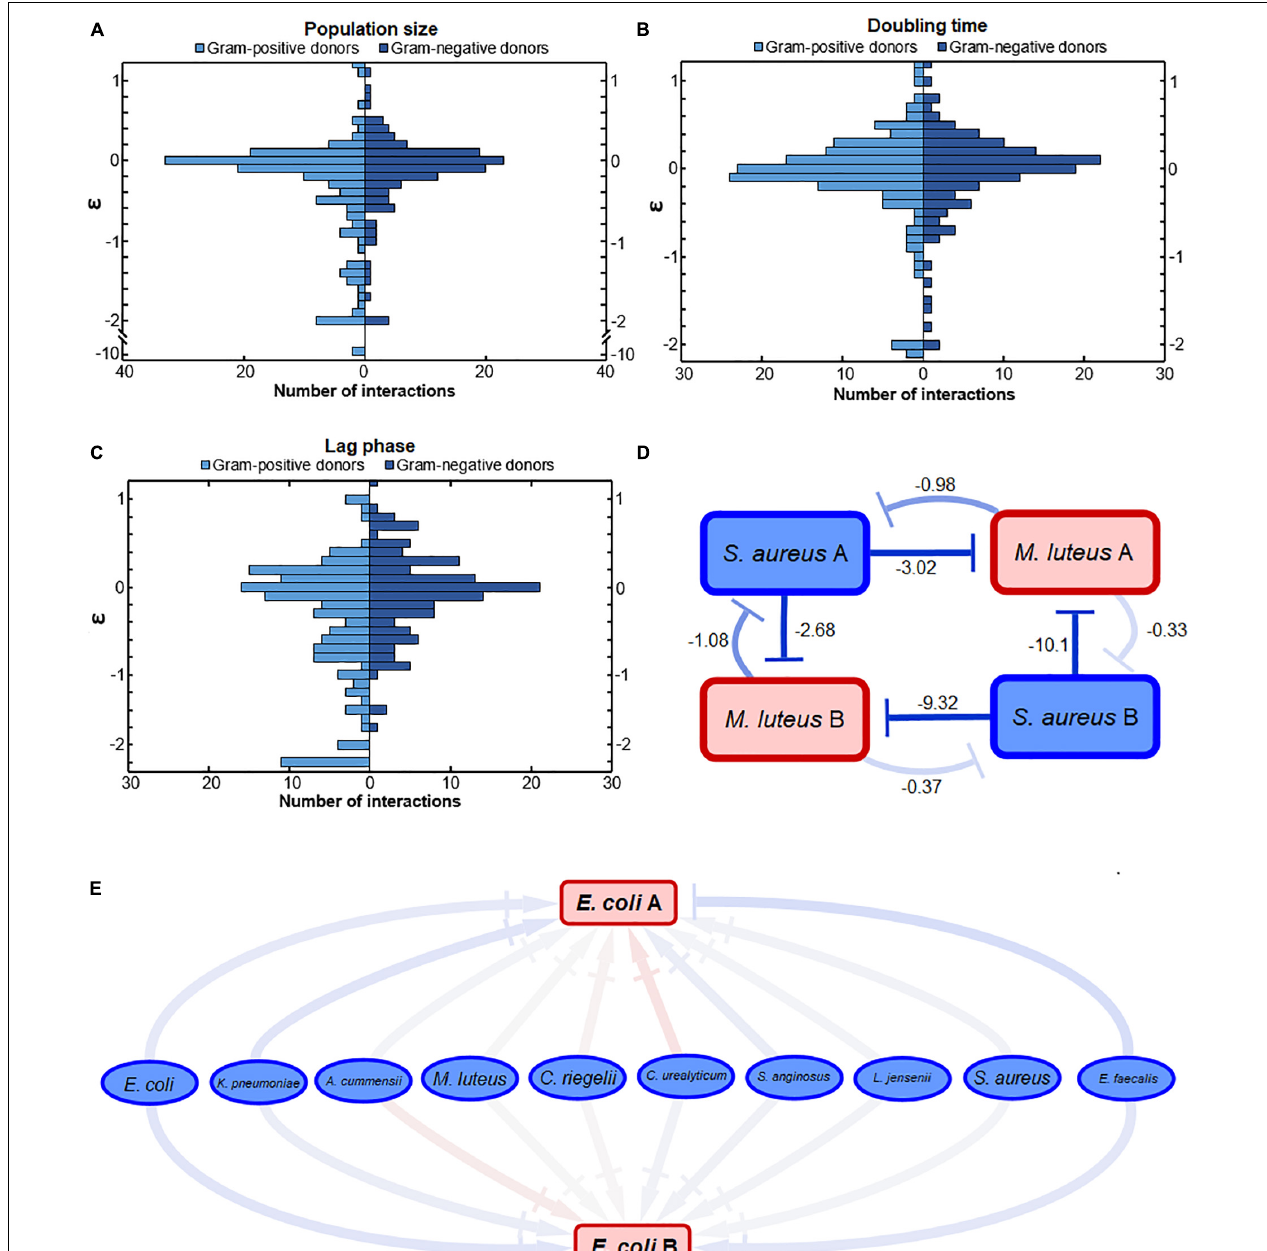
FIGURE 3 | The effect of conditioned media from Gram-positive and Gram-negative donors. (A) The effect on population size was significantly different. Conditioned media of Gram-positive donors led to a wider range of growth effects compared to the effect of Gram-negative donors ( p = 0.032). Mostly, the Gram-positive donors more often had a strong negative effect on population size compared to the Gram-negative donors. (B) Gram-positive and Gram-negative donors did not have a significantly different effect on the doubling time interactions. The distributions of interactions between Gram-positive and Gram-negative donors was relatively similar ( p = 0.17). (C) Gram-negative donors induced a more conserved response on the lag phase compared to Gram-positive donors. This could suggest that the Gram-negative bacteria produce a more similar environment compared to Gram-positive bacteria. The distribution of interactions affecting the lag phase of acceptors by Gram-positive and Gram-negative donors was significantly different ( p = 0.0014). (D) Strong negative bacterial interactions in conditioned media. Two pathogenic S. aureus donors inhibited the population size of two commensal M. luteus isolates strongly. The numbers next to the connectors show the ε -values of the interactions. The darker the color of the connector, the stronger the interaction. Red indicates positive, whereas blue indicates negative interactions. (E) Weak interaction effects of commensal donor conditioned media on the population size of two pathogenic E. coli isolates. Color gradient of the connectors indicate interactions strength, with | → connectors indicating a weak-to-neutral interaction [log(0.8) = –0.22 < ε < log(1.2) = 0.18]. The darker the color of the connector, the stronger the interaction. Red indicates positive, whereas blue indicates negative interactions. Significance of results was calculated using Welch’s unequal variances t